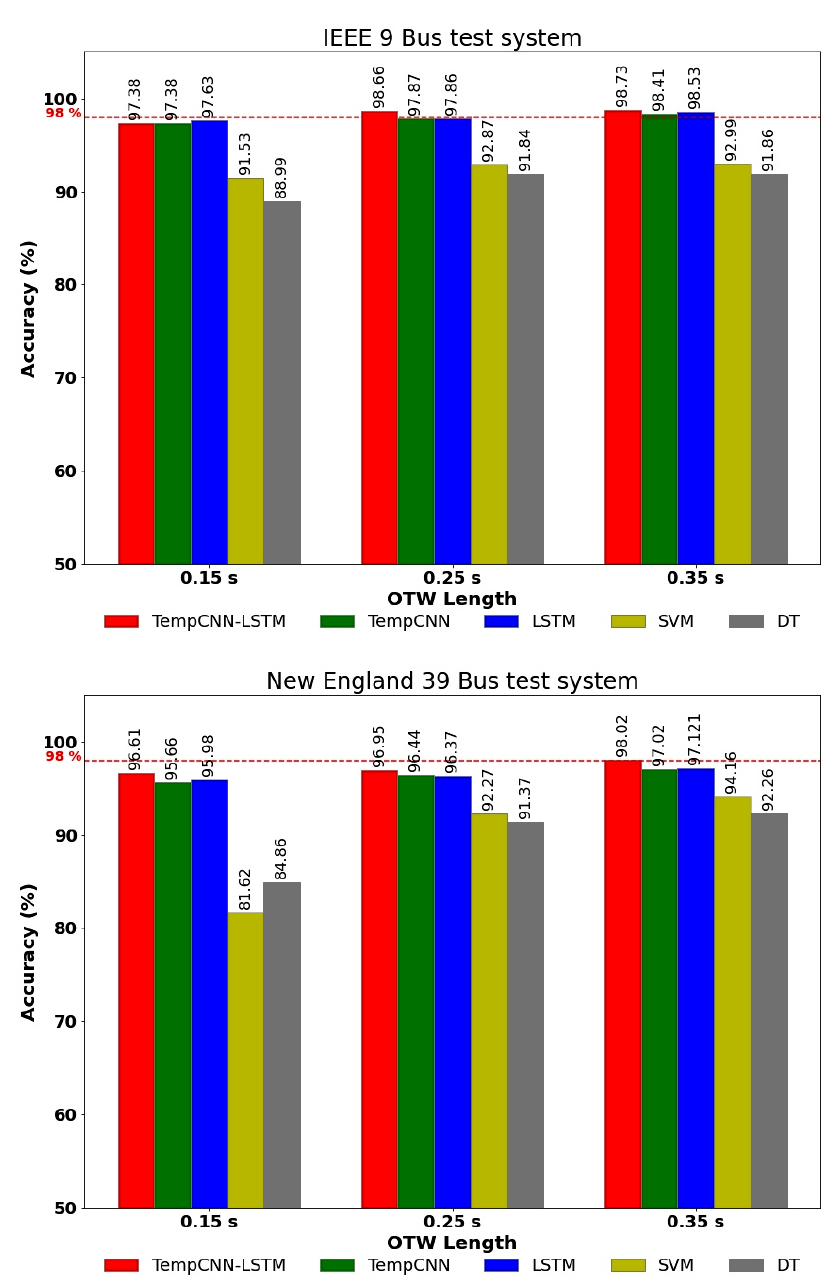
Figure 14. Performance with different OTW lengths on test